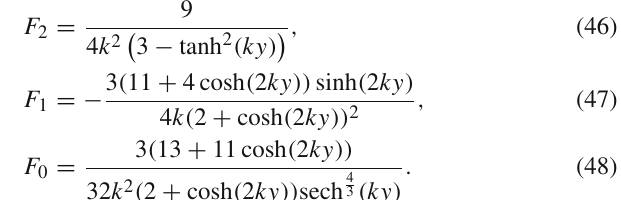
fundamental 5-dimensional gravitational constant G 5 reads ≈ 4 . 681 G / k G 5 = G 4 / N 2 4 0